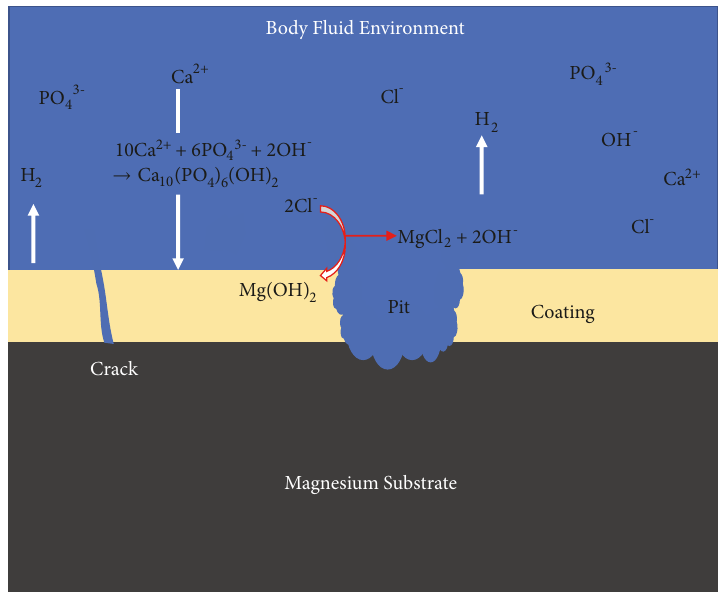
Figure 7: Schematic diagram illustrating the corrosion failure and species present for surface modified magnesium and its alloys.